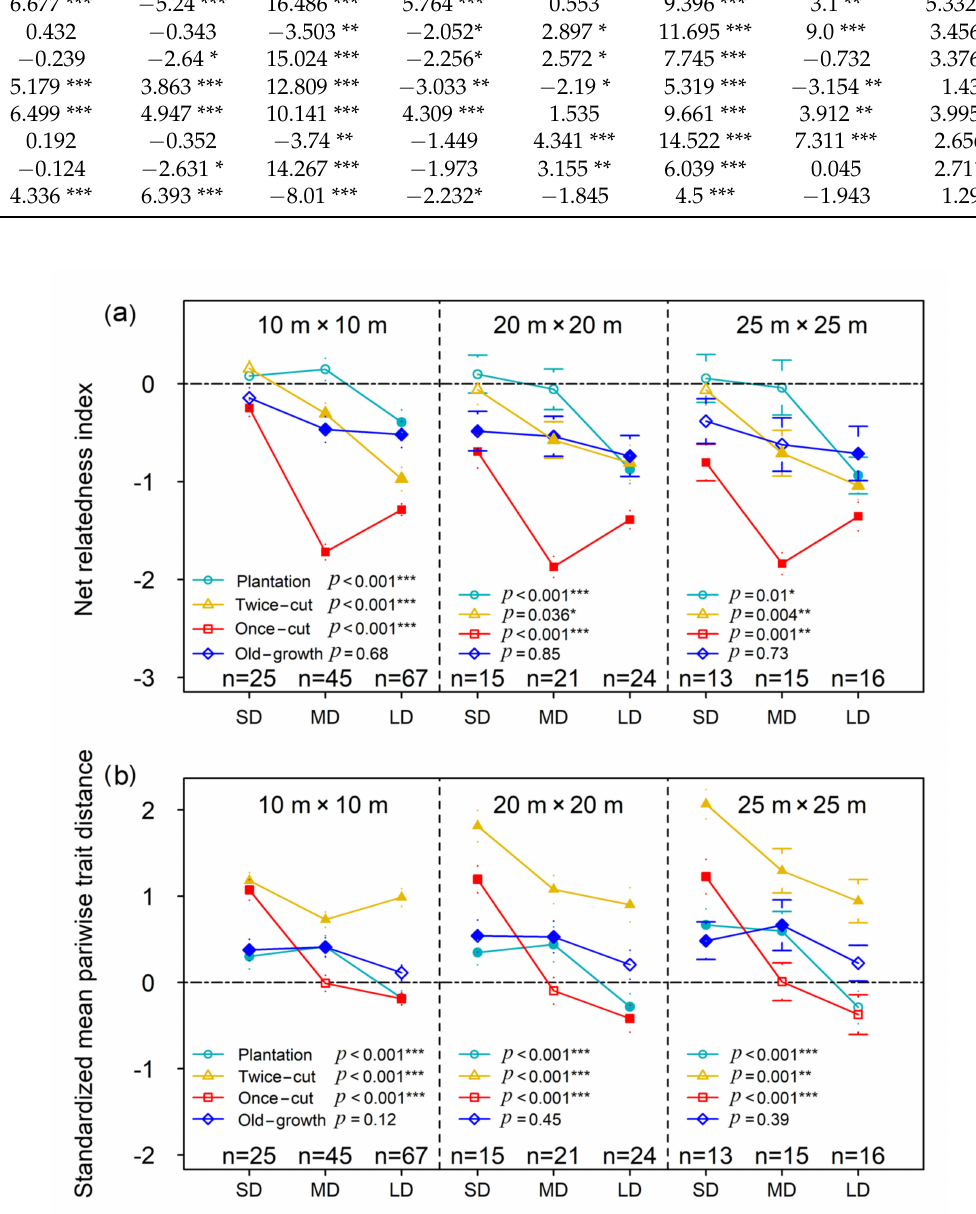
Figure 3. Phylogenetic ( a ) and functional trait structure ( b ) (mean ± SE) of different diameter classes in four disturbance plots at three spatial scales. Solid markers represent means of NRI or PW that are significantly different from 0 and the open markers represent non-significant differences based on the Wilcoxon test. “*”, “**”, and “***” represent p < 0.05, p < 0.01, and p < 0.001,